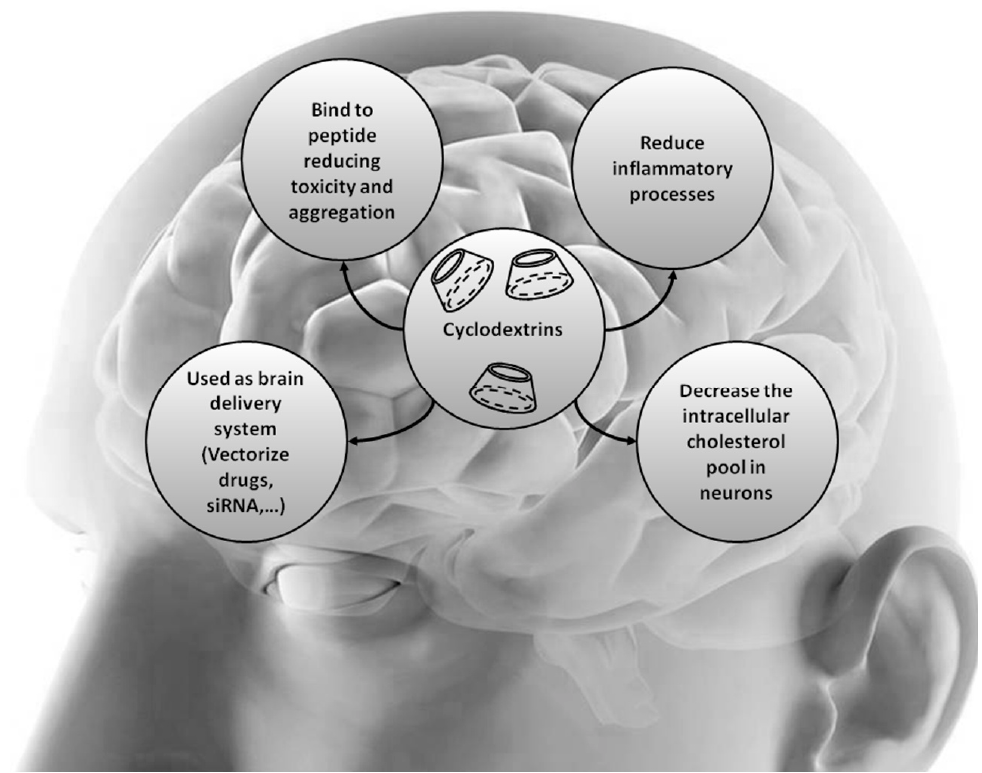
Figure 2. Molecular mechanisms mediated by β -CDs in Alzheimer’s, Parkinson’s, Hugtington’s, Niemann-Pick Type C diseases. Niemann-Pick Type C disease is characterized by intracellular accumulation of unesterified cholesterol and glycosphingolipids. Alzheimer’s, Parkinson’s and Huntington’s diseases are charaterized by abnormal aggregation of peptides leading to the neurodegenerative processes. β -CD family acts at several levels and shows beneficial effects in these neurodegenerative diseases.